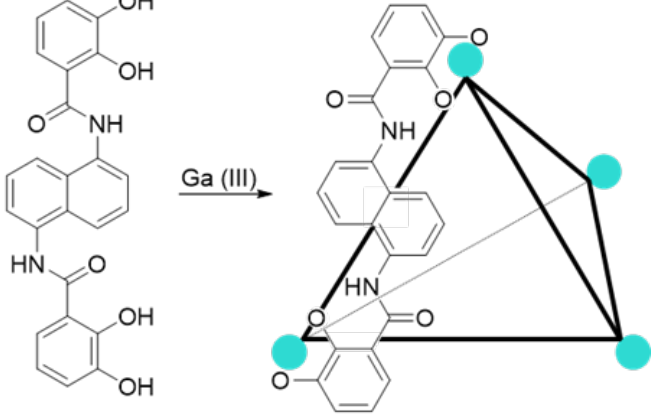
Figure 1. Tetrahedral capsule.